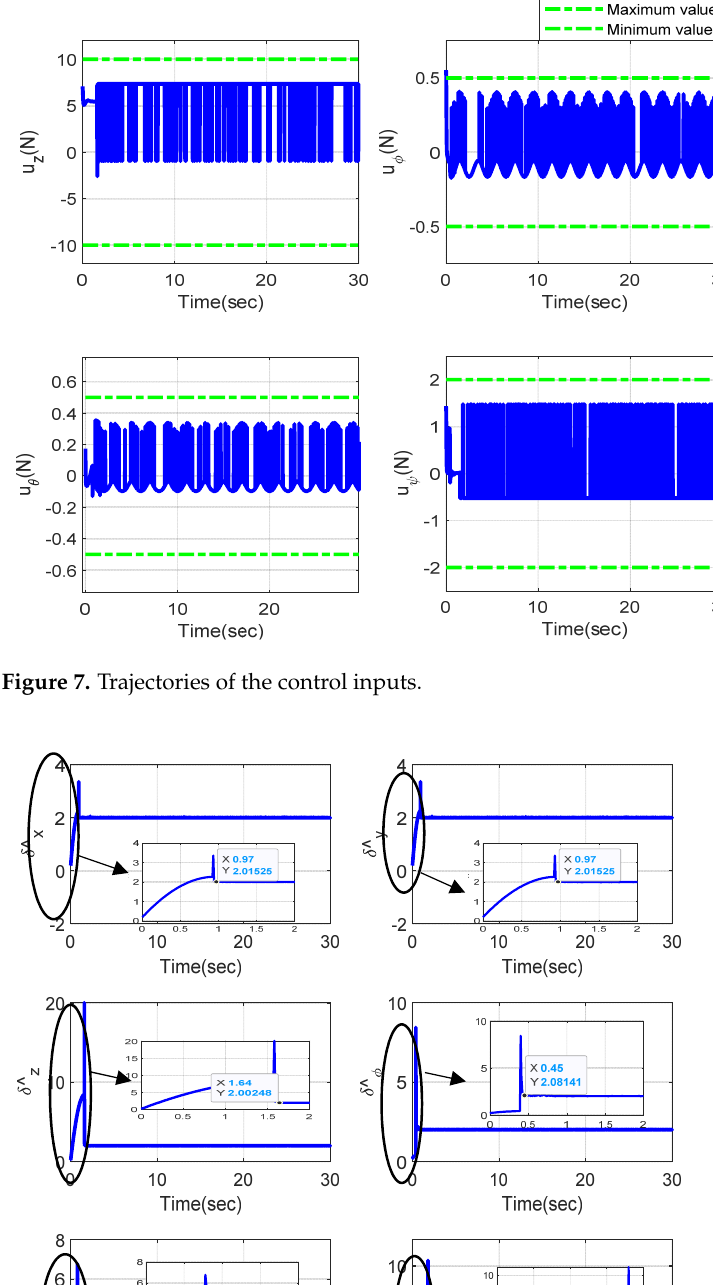
Figure 6. Time responses of the non-singular terminal sliding surface.